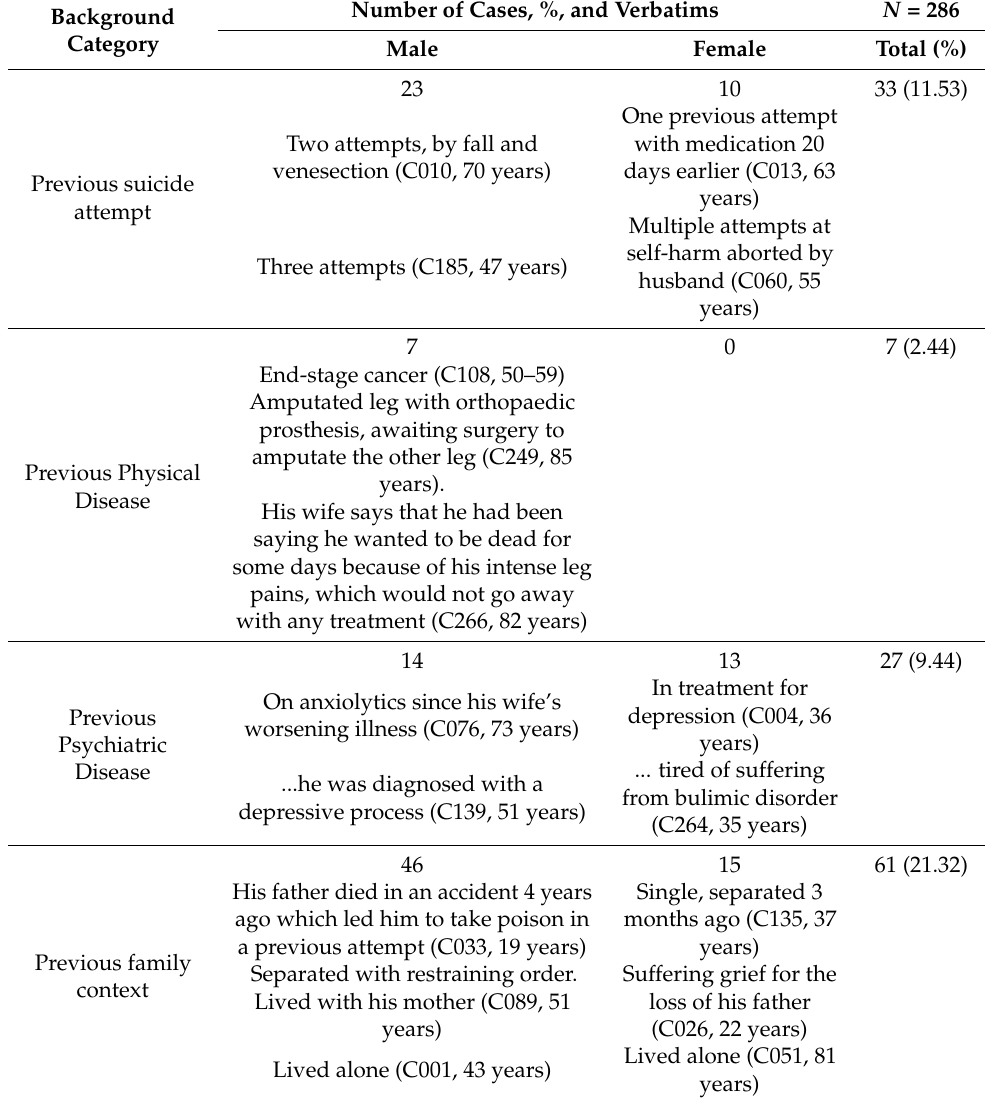
Table 3. Category: Background. Subcategories: number of cases, percentages, and verbatims of forensic observations in males and